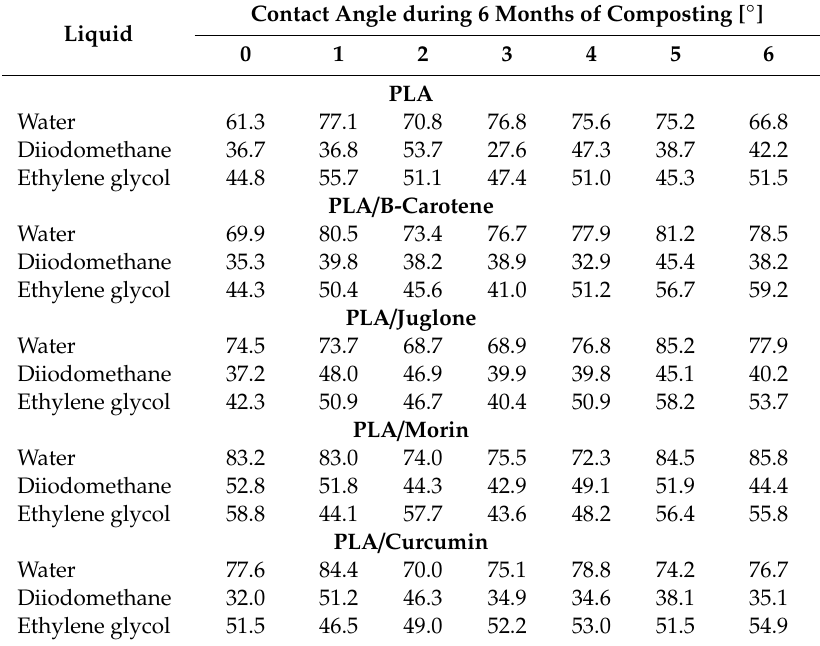
Table 1. Contact angle obtained using water, diiodomethane, and ethylene glycol for PLA samples during 6 months of composting.